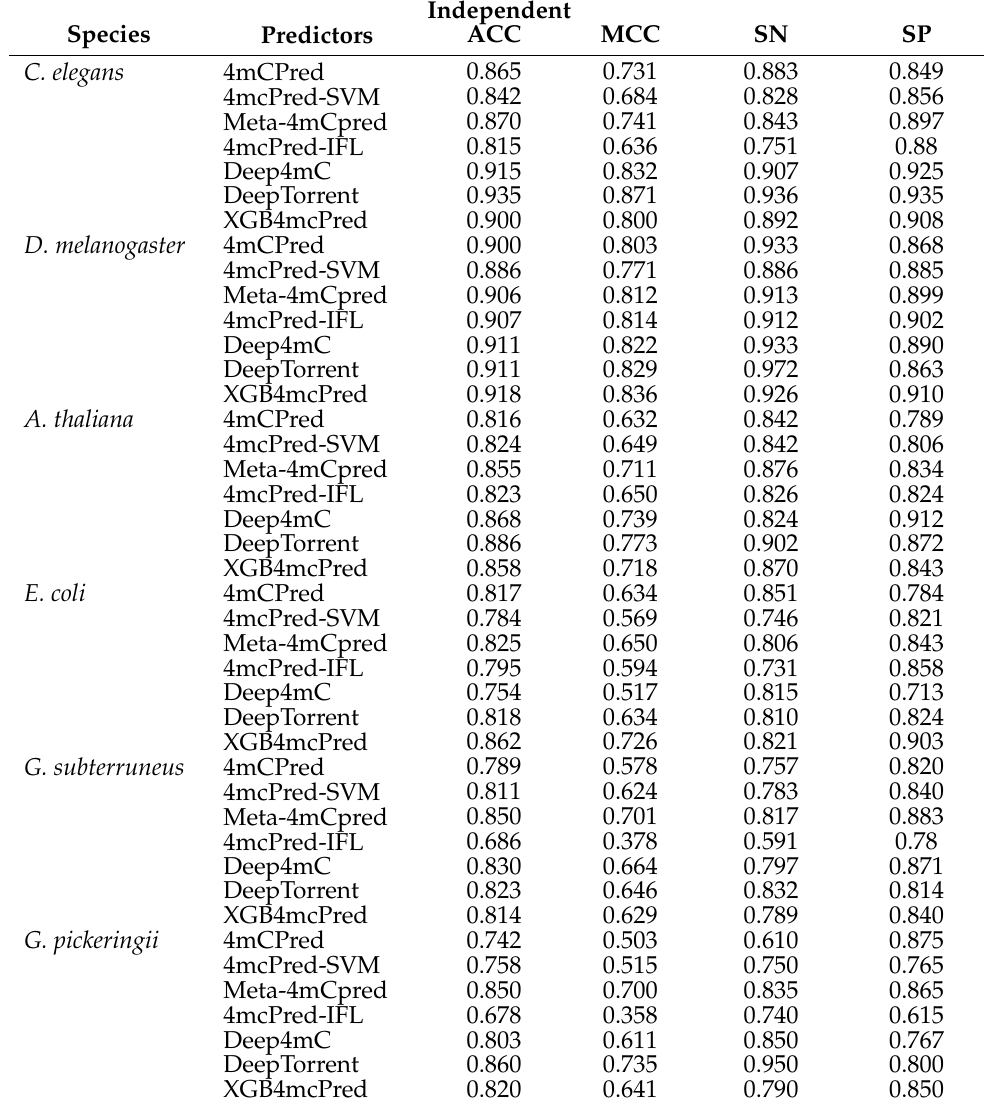
Table 4. Performances of the proposed XGB4mcPred and five state-of-the-art predictors on indepen- dent datasets from six